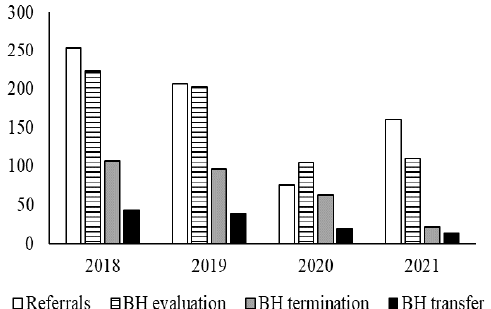
Figure 3. The number of behavioral health evaluations, referrals, terminations, and transfers at the SBHCs from 2018 to 2021.